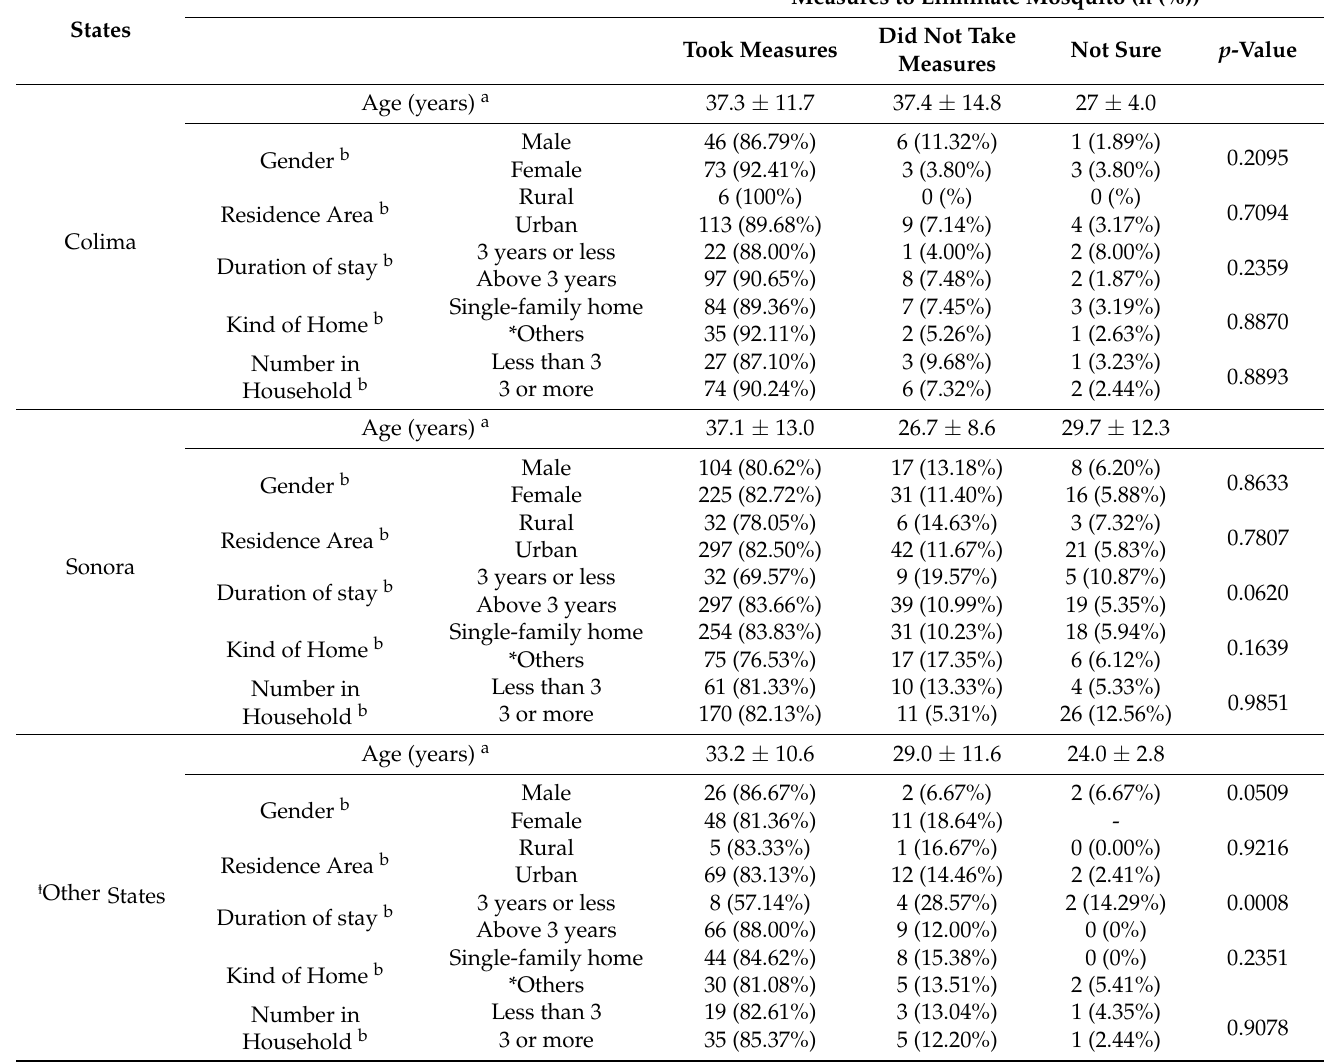
Table 1. Demographic Characteristics by people who took measures to eliminate mosquitoes in their households in the past year.